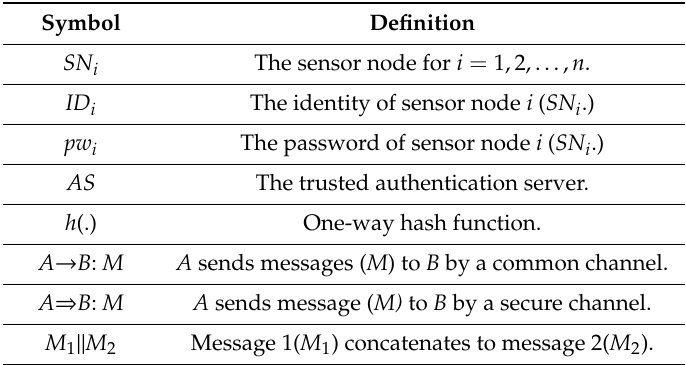
Table 1. The symbol system applied by the proposed